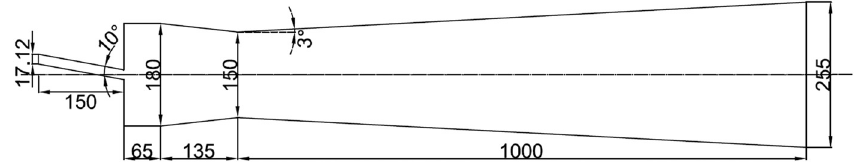
Figure 2: A sketch of a geometric model ( mm )